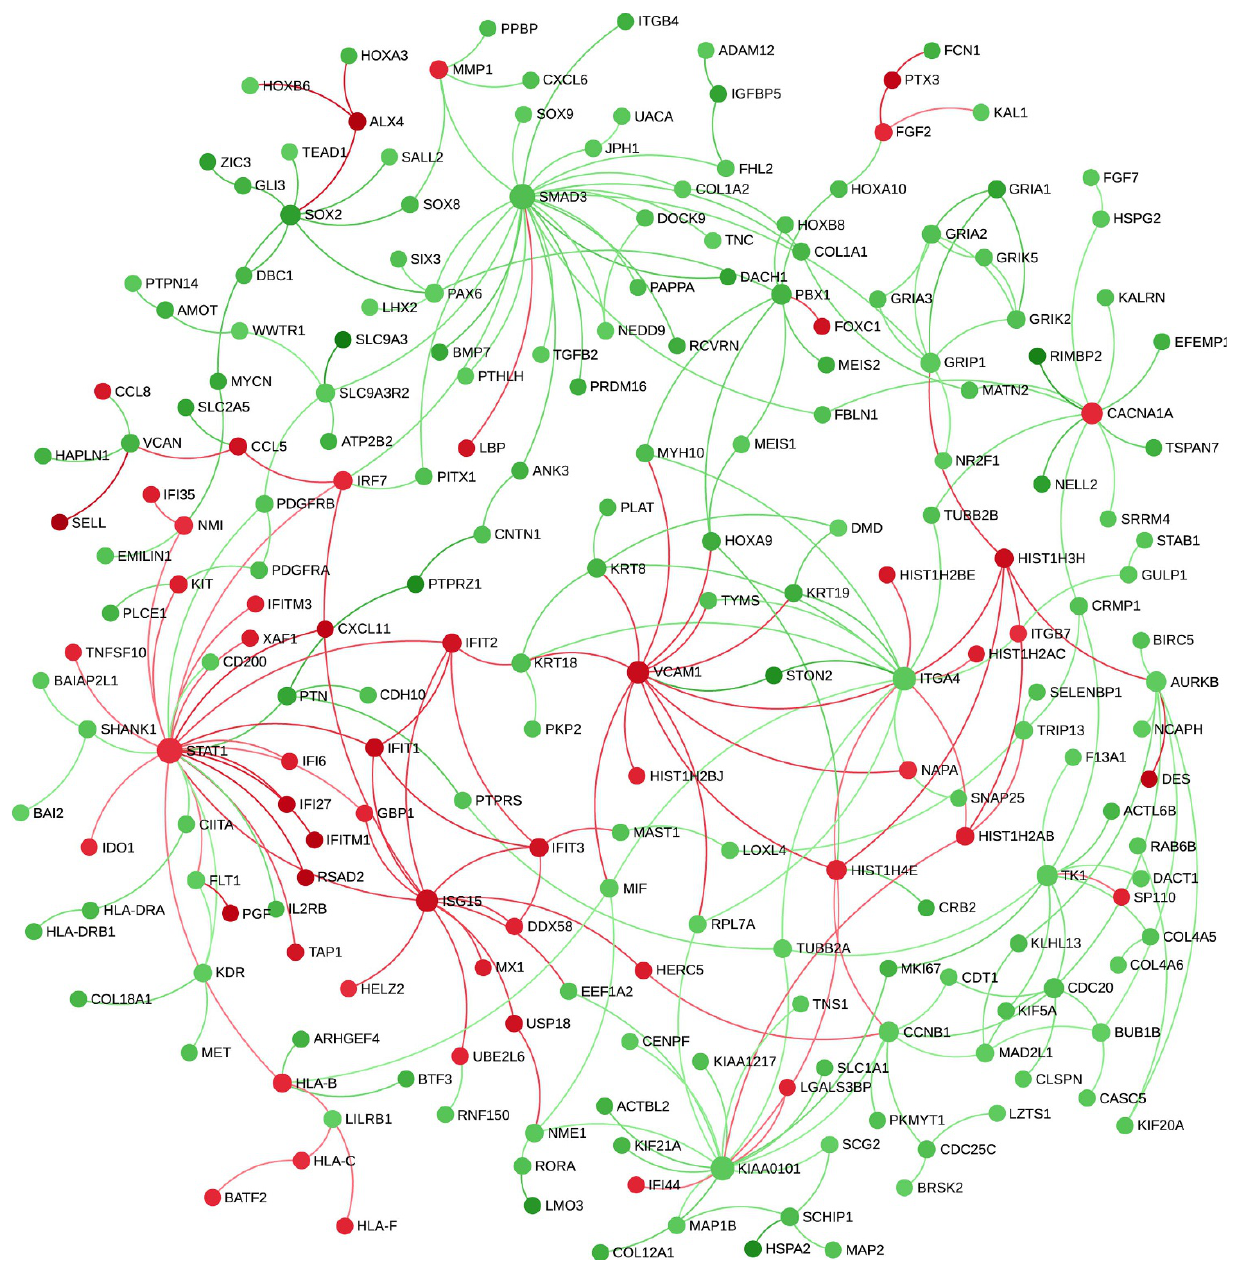
Figure 8 | Network of expression changes due to infection in the IRF5 (cid:2) / (cid:2) mutant compared to parent KOLF2 cells. Green ¼ decreased expression; Red ¼ increased expression. RNA-Seq data for differentially expressed genes due to infection (that is, differences between IRF5 (cid:2) / (cid:2) mutant infected/ uninfected compared to parent KOLF2 cells infected/uninfected) were submitted to NetworkAnalyst 45 and interconnected based on known protein:protein interactions